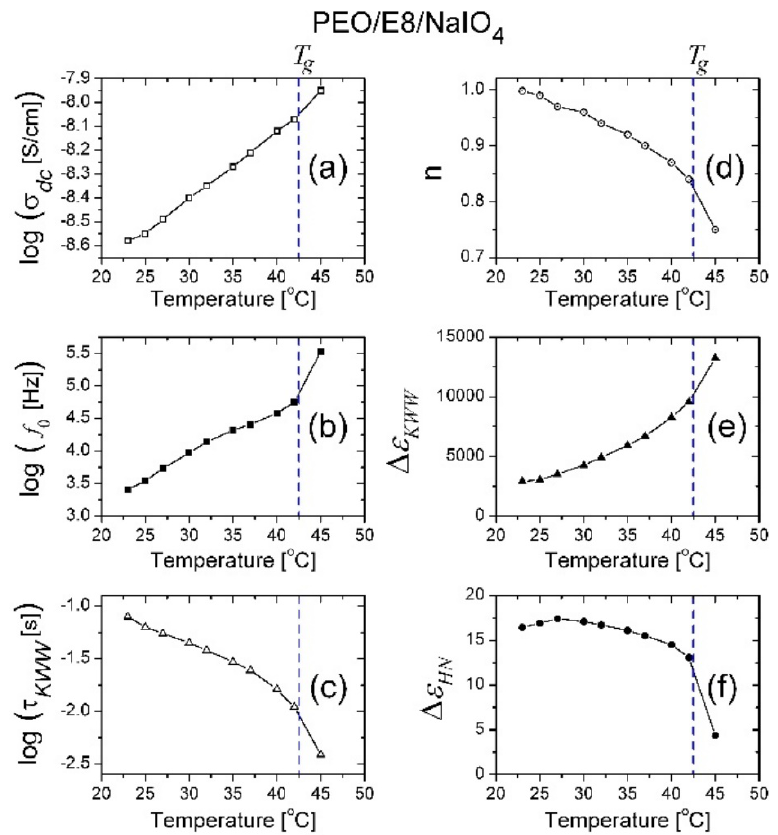
Figure 16. Temperature dependencies of the values of parameters derived by the best fits using Equation (2) (KWW + HN model): σ dc ( a ); f 0 ( b ); τ KWW ( c ); n ( d ); ∆ ε KWW ( e ); ∆ ε HN ( f ). The fits were performed on the ε (cid:48)(cid:48) ( f ) spectra of the PEO/E8/NaIO 4 composite (the fits in Figure 15) that correspond to temperatures from 23 ◦ C to 45 ◦ C.